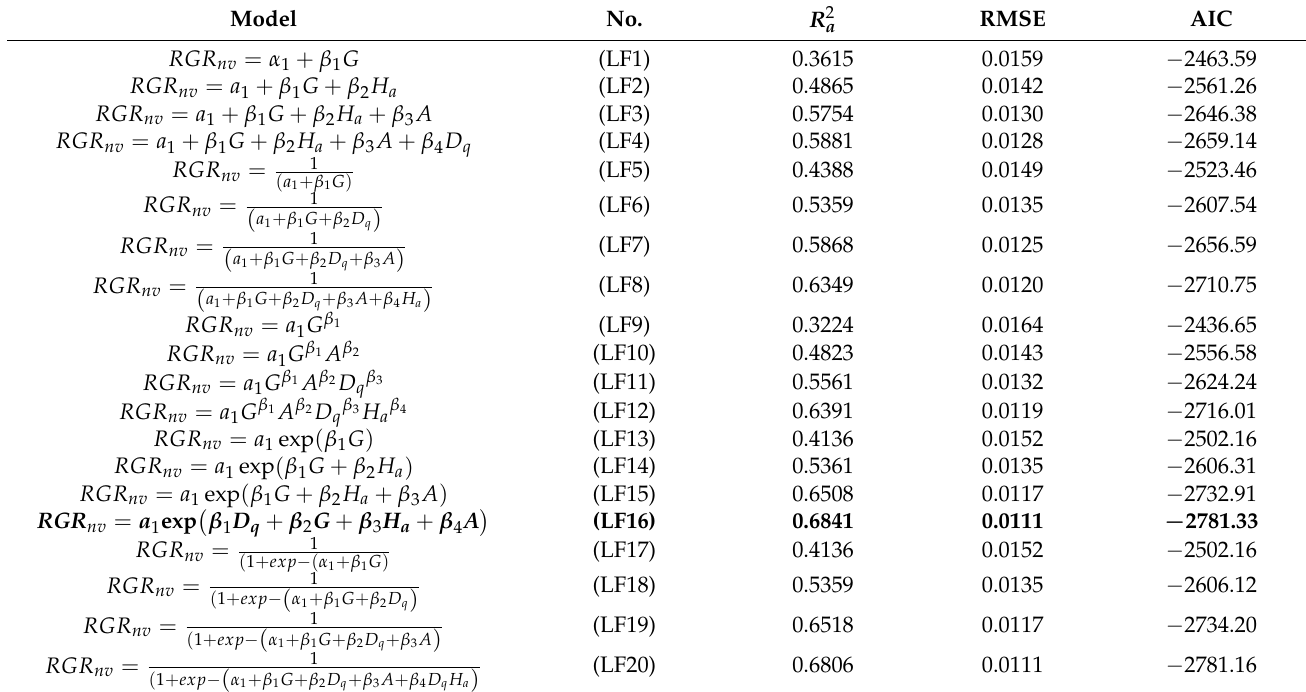
Table A1. Goodness-of-fit statistics of the basic RGR nv equations for larch forest (LF).